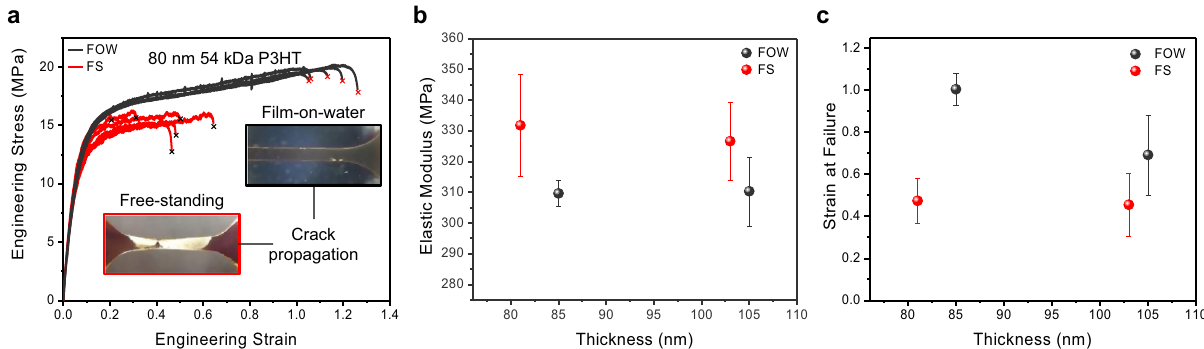
Fig. 3 Comparison of 25 kDa P3HT FS and FOW mechanical properties at ~105 and ~80 nm using the 8 mm-gauge geometry. a Representative stress vs. strain pro fi les of 80 nm P3HT for both FOW and FS tensile test. Insert is an optical comparison of a FS and FOW P3HT at failure. b Modulus and c strain at failure of P3HT in both FOW and FS measurements. Error bars represent the SD of the characterized mechanical properties.